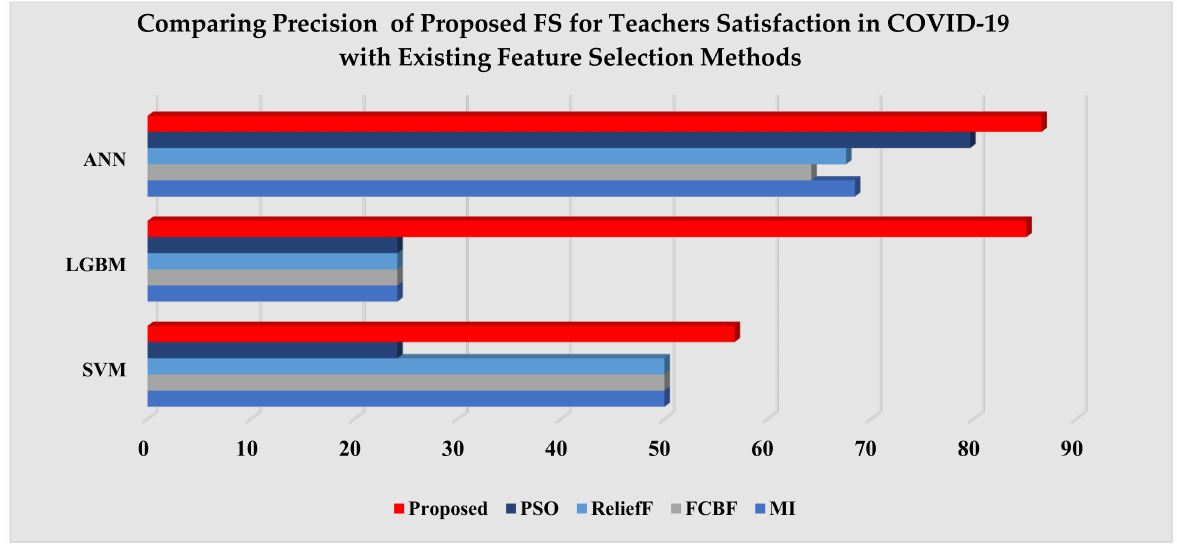
Figure 4. Comparing Precision of Proposed FS for Teachers Satisfaction in COVID-19 with Existing Feature Selection